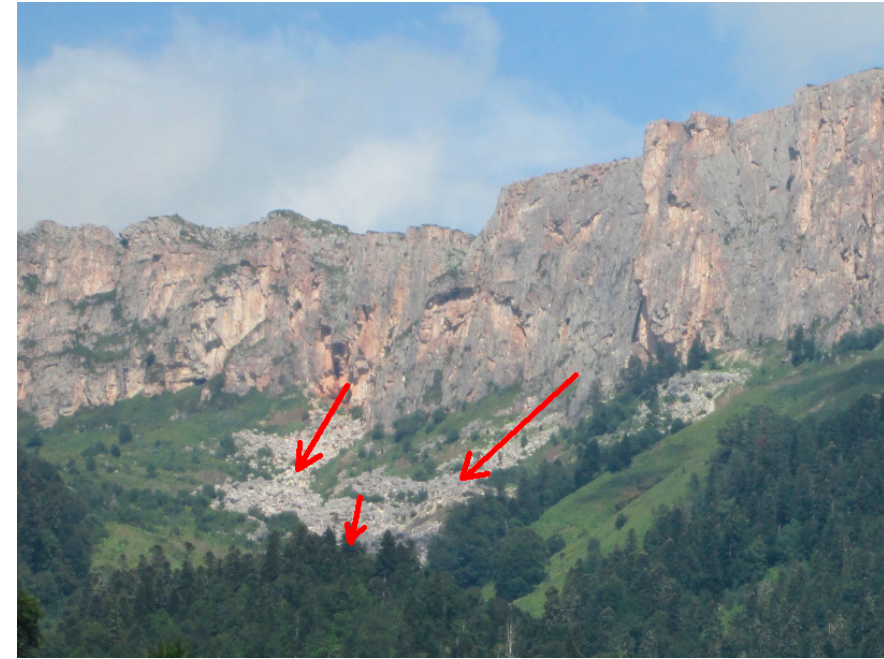
Figure 4. Colluvial deposits at the toe of the cuesta cliff of the Stonesea Range. Arrows indicate directions of clast transport.